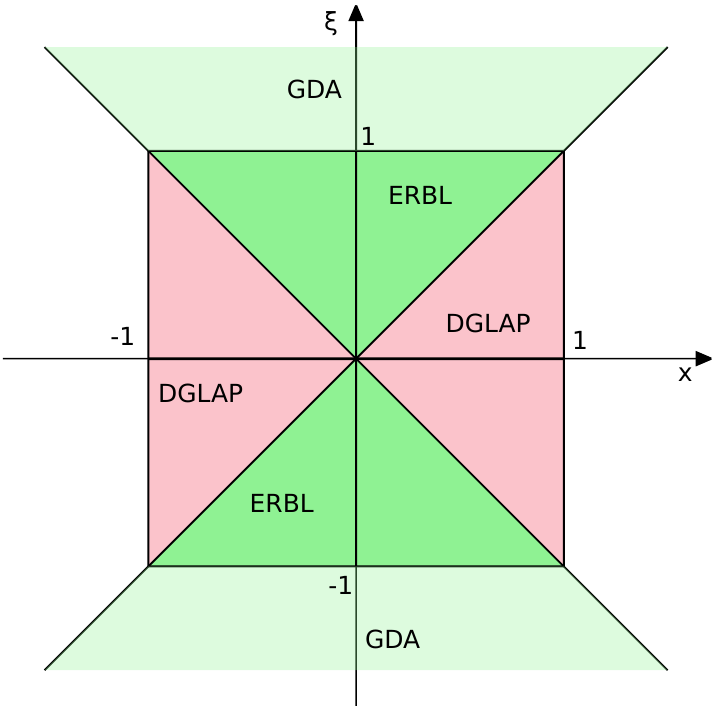
Figure 2. The GPD definition domain in x and ξ . The so-called DGLAP (or outer) region for which x ξ is shaded in pink, while the ERBL (or inner) region for which | | ≥ | | The ERBL region can be extended for Distribution Amplitude [45–48] through analytic continuations thanks to the crossing